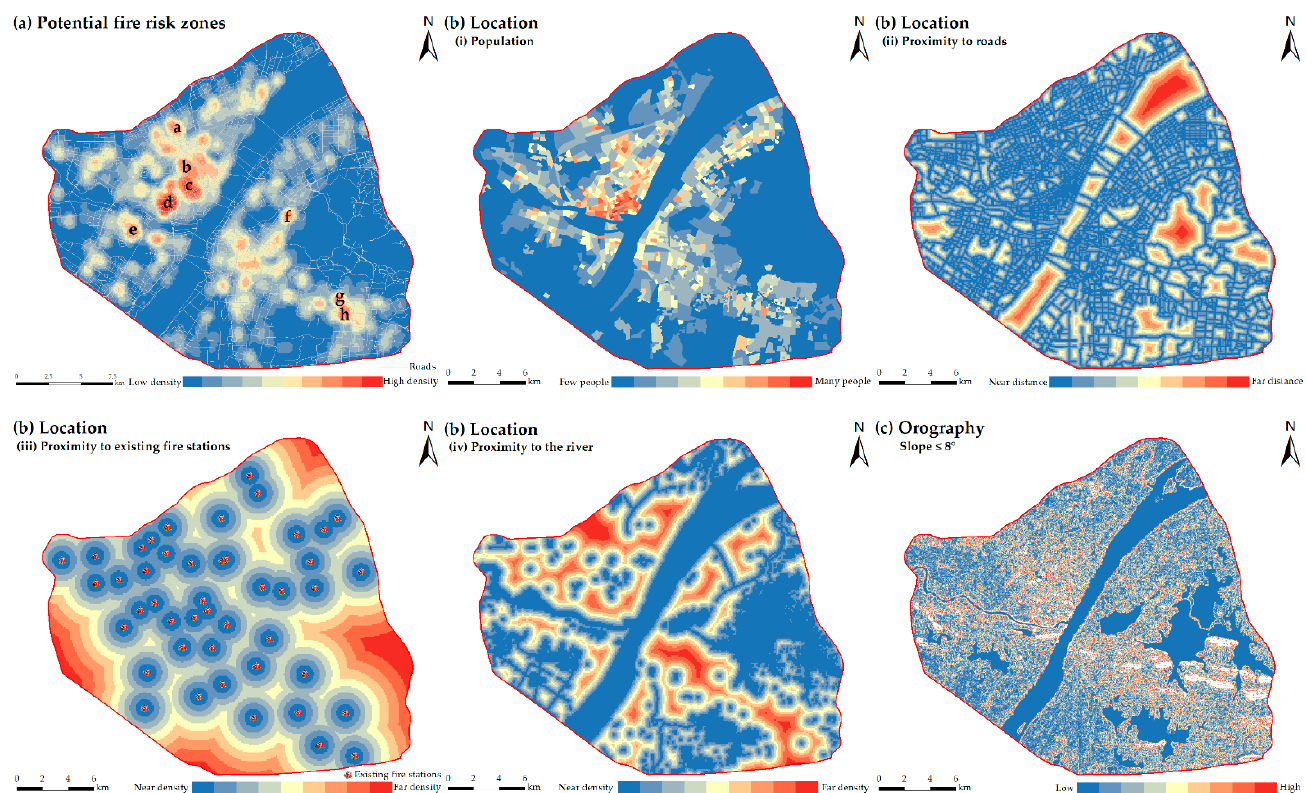
Figure 8. Spatial distribution of evaluation criteria layer (includes potential fire-risk zones, population, proximity to roads, proximity to existing fire brigades, proximity to the river, and orography). Table 9. Evaluation criteria reclassified with the corresponding scores and weight of criteria. Fire-Risk Zone Location